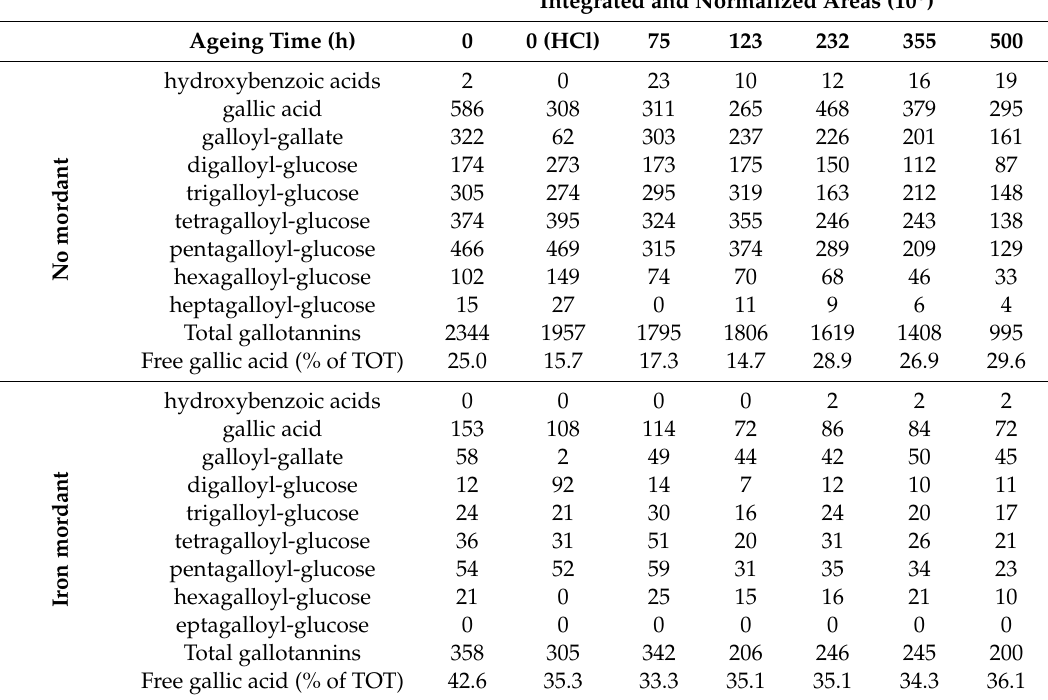
Table 2. Normalized peak areas of all identified compounds in the extracts of yarns dyed with oak gallnuts using either no mordant or iron mordant, as a function of ageing time. The total gallotannins content and the percentage of free gallic acid with respect to total identified compounds are also presented for each